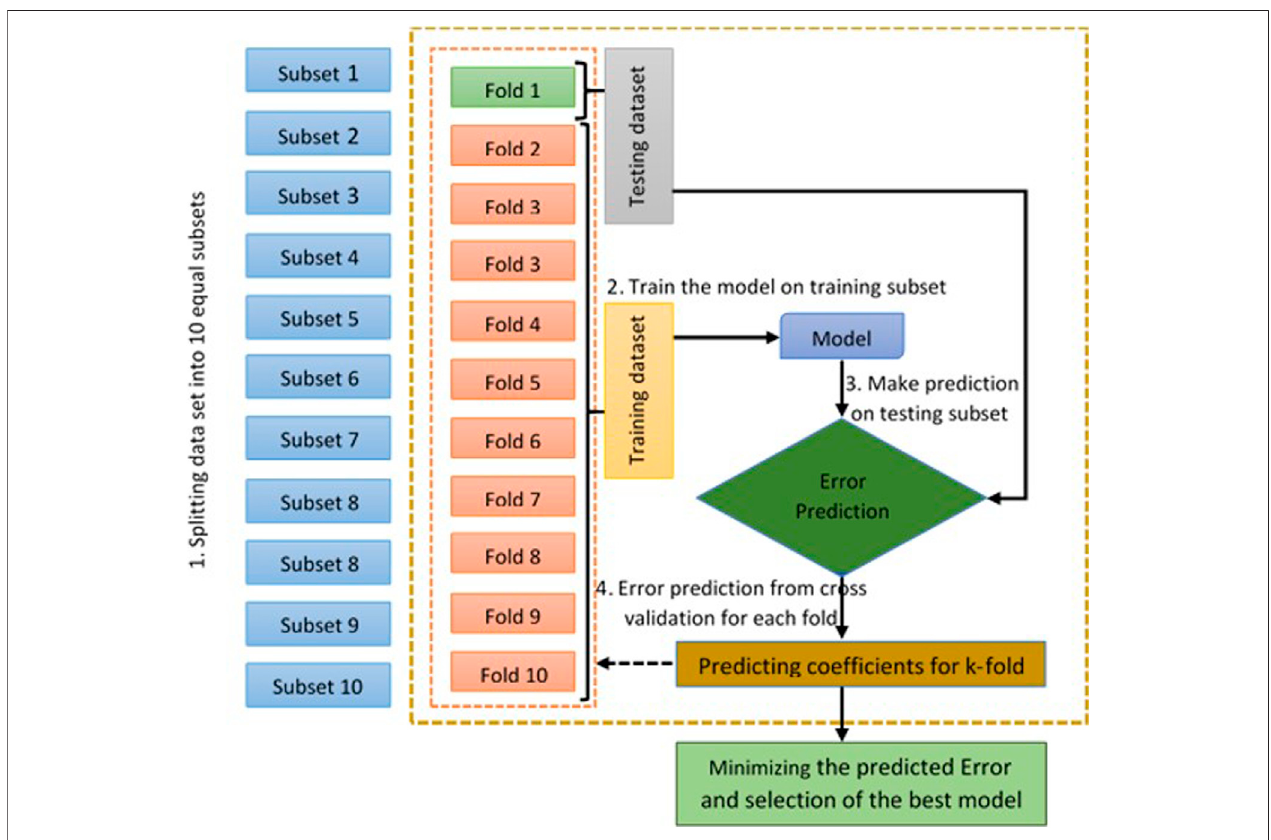
FIGURE 4 | Flow diagram of K-fold cross-validation.